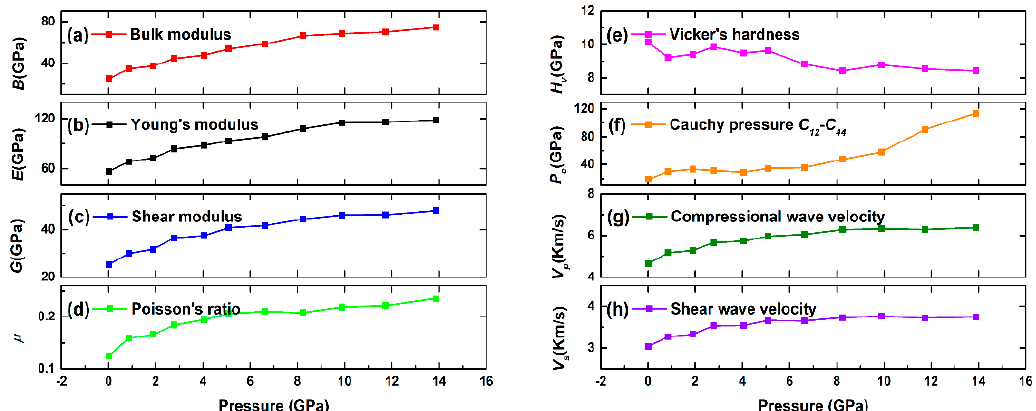
Figure 4. The calculated value of elastic modulus, Poisson’s ratio, hardness and wave velocity of pyrophyllite [Al 4 Si 8 O 20 (OH) 4 ] under different pressure. ( a ) Bulk modulus ( B ); ( b ) Young’s modulus ( E ); ( c ) Shear modulus ( G ); ( d ) Poisson’s ratio ( μ ); ( e ) Vicker’s hardness ( H v ); ( f ) Cauchy pressure C 12 – C44 ( P c ); ( g ) Compression wave velocity ( V p ); ( h ) Shear wave velocity ( V s ). Table 5. The calculated bulk modulus ( B ), Young’s modulus ( E ), shear modulus ( G ), Poisson’s ratio ( μ ), Vickers hardness ( H v ), Cauchy pressure ( P c ), compression wave velocity ( V p ) and shear wave velocity ( V s ) of pyrophyllite [Al 4 Si 8 O 20 (OH) 4 ] under different pressure, compared with experimental data.